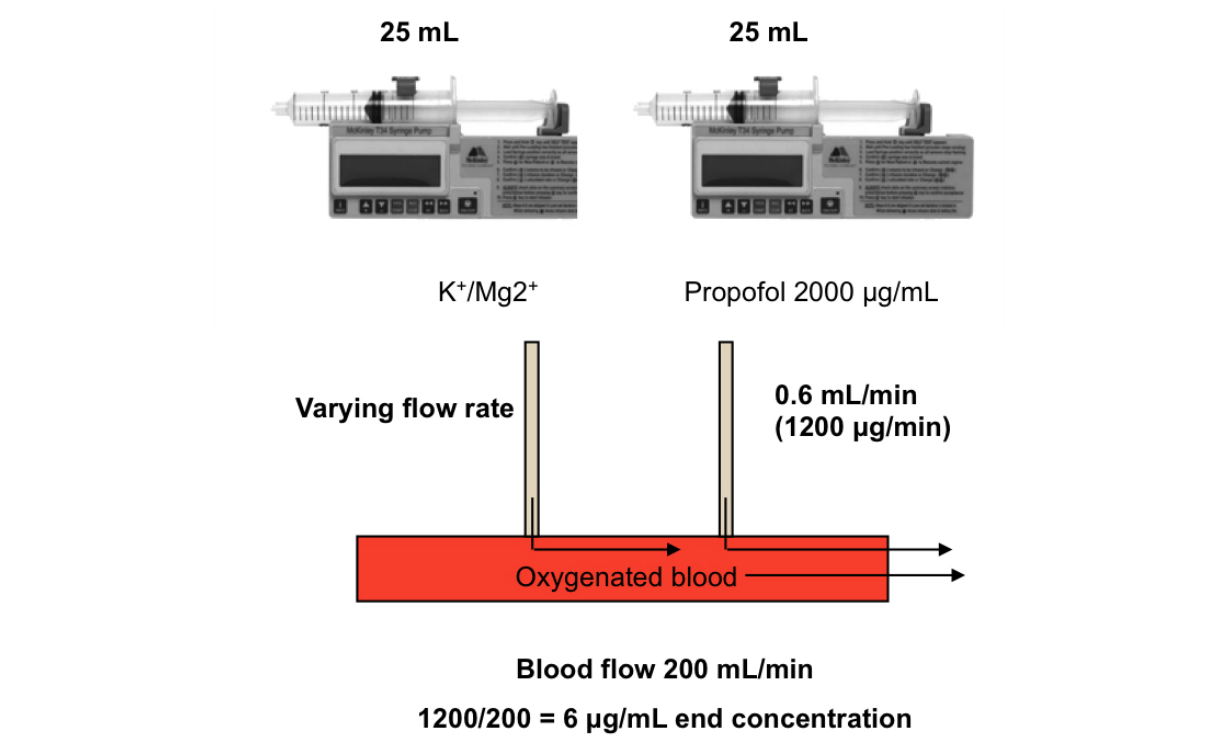
Figure 1. CABG warm blood cardioplegia. Propofol is first diluted from 10,000 μg/mL to 2000 μg/mL using 0.9% sodium chloride. The diluted propofol solution is added to the cardioplegia by attaching an additional syringe pump to the line downstream of the blood oxygenator. This method is identical to that used for adding potassium and magnesium to the oxygenated blood. The syringe driver is set to 0.6 mL/min resulting in a 6 μg/mL supplementation of the blood/cardioplegia mix during delivery. For the placebo group, cardioplegia is supplemented with placebo in the same manner as described for propofol. In the event addition of propofol is indicated, this is substituted with an equivalent volume of intralipid.